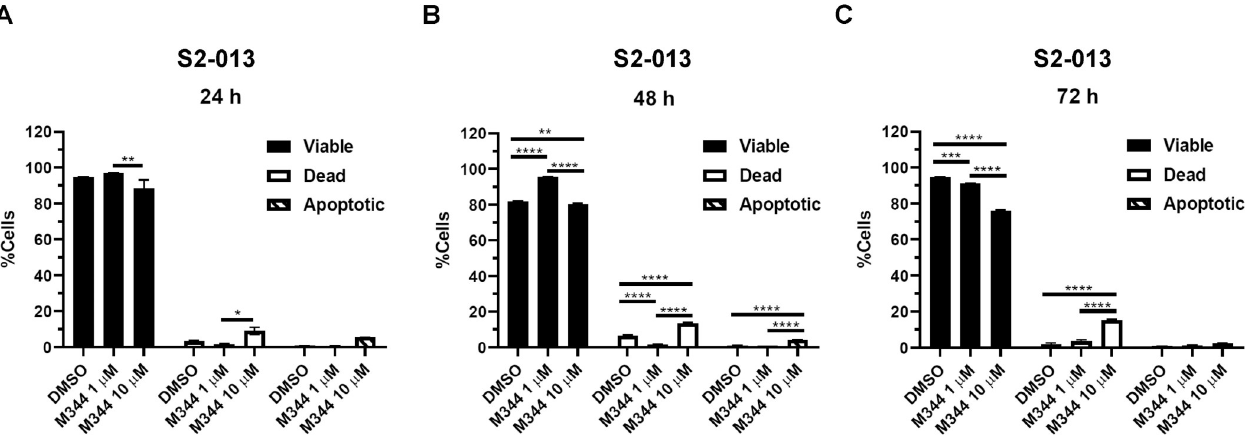
Fig 4. M344-induced apoptosis is apparent by 48 hours and necrosis peaks at 72 hours. S2-013 cells were treated with 0.1% DMSO control or M344 (1 μ M or 10 μ M) for 24, 48, or 72 hours. Caspase-3 and caspase-7 cleavage was simultaneously analyzed by using the CellEvent TM Caspase-3/7 Green Flow Cytometry Assay Kit. The SYTOX TM AADvanced TM Dead Cell Stain included in the kit identified necrotic cells. Each error bar represents the standard error of the mean. Statistical comparisons of the results were done using a Two-way ANOVA with Tukey’s multiple comparisons test. The asterisks indicate the following p values: � < 0.05, �� < 0.01, ��� < 0.001, ���� < 0.0001.